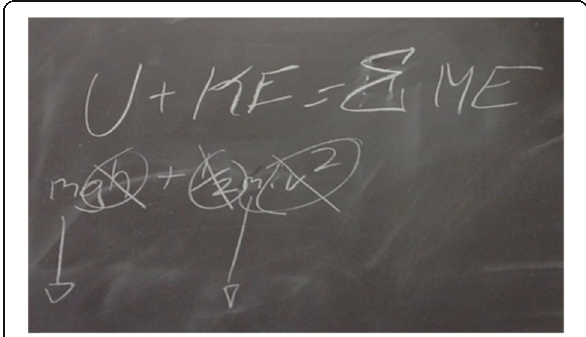
Fig. 3 Christopher ’ s explanation. Note: ME = mechanical